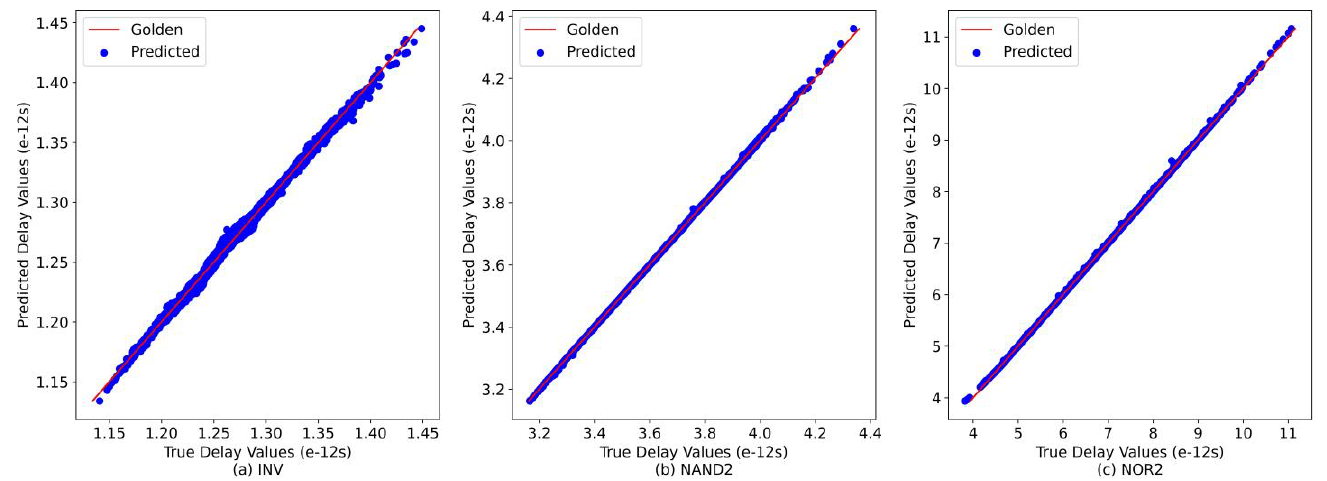
Figure 7. Model prediction accuracy comparison for: ( a ) INV gate; ( b ) NAND2 gate; ( c ) NOR2 gate.